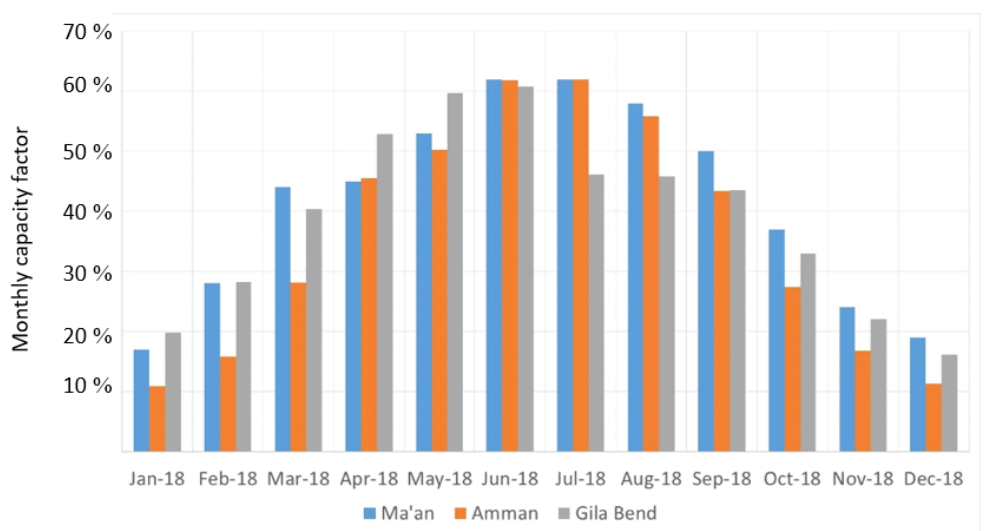
Figure 12. Bar graph comparison of monthly capacity factors of Solana Gila Band, Solana Amman, and Solana Ma’an from SAM.